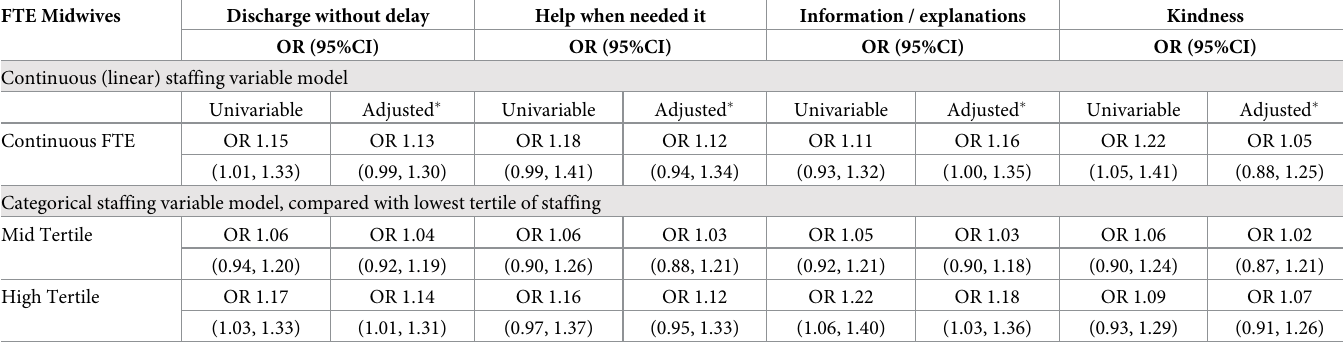
Table 5. Summary of univariable and adjusted regression analysis. Estimated odds of a positive response (whole Trust staffing).